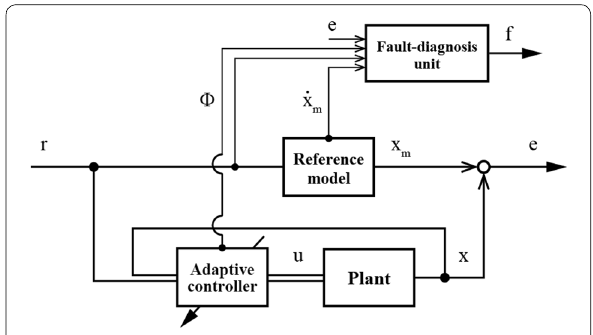
Fig. 9 System diagram of the MRAC and fault-diagnosis unit